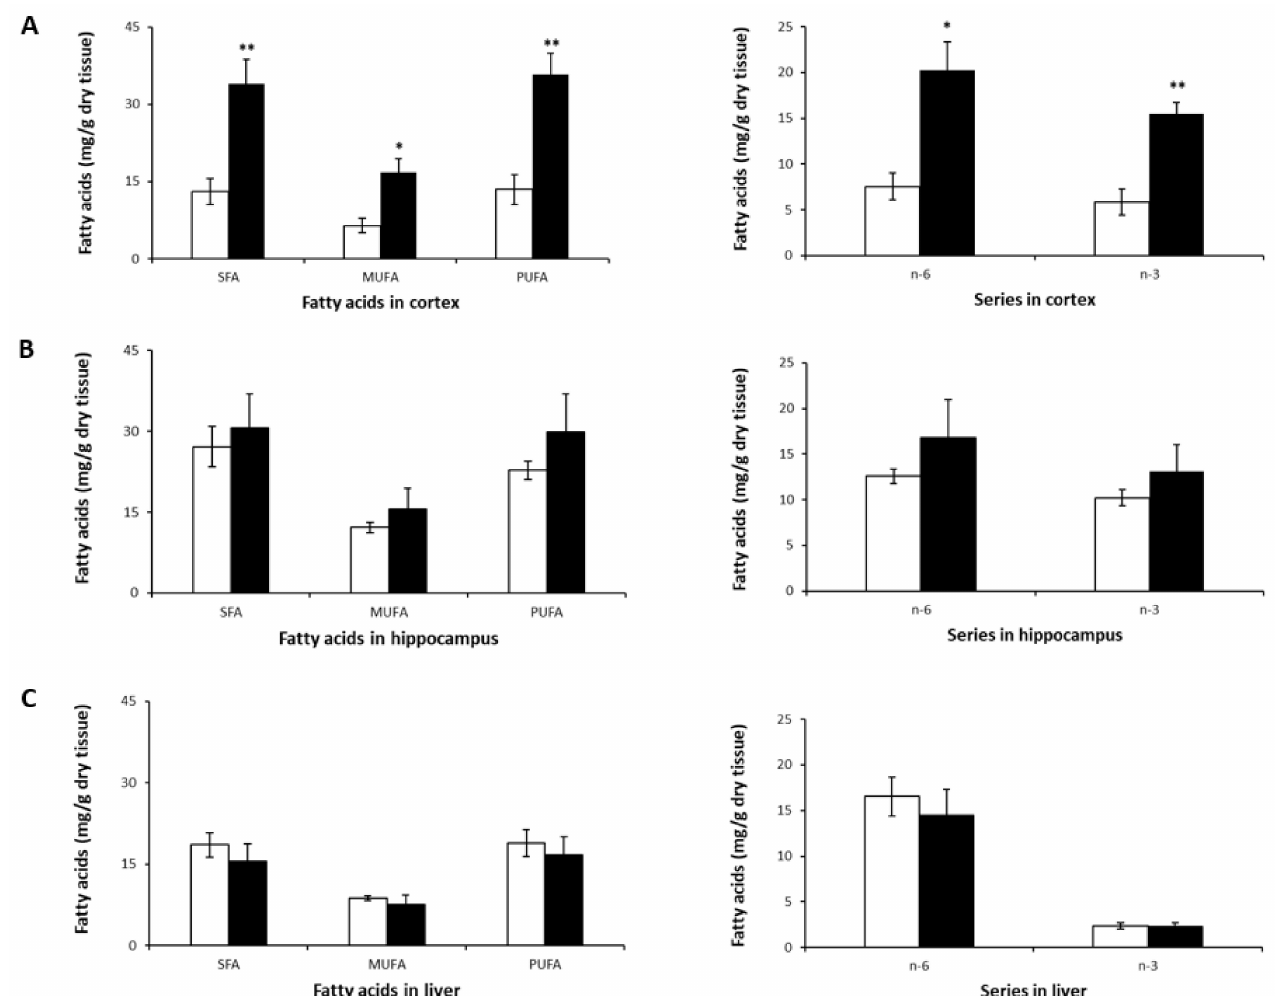
Figure 3. SFA, MUFA, PUFA, n-3, and n-6 profiles in murine cortex ( A ), hippocampus ( B ), and liver ( C ) after 8-week NL treatment. Results are shown for the control (open bars) and NL (closed bars) groups. Results are expressed as mean ± SD ( n = 5/group). Statistical differences comparing the control and NL groups are shown for each tissue (* p < 0.05, ** p <